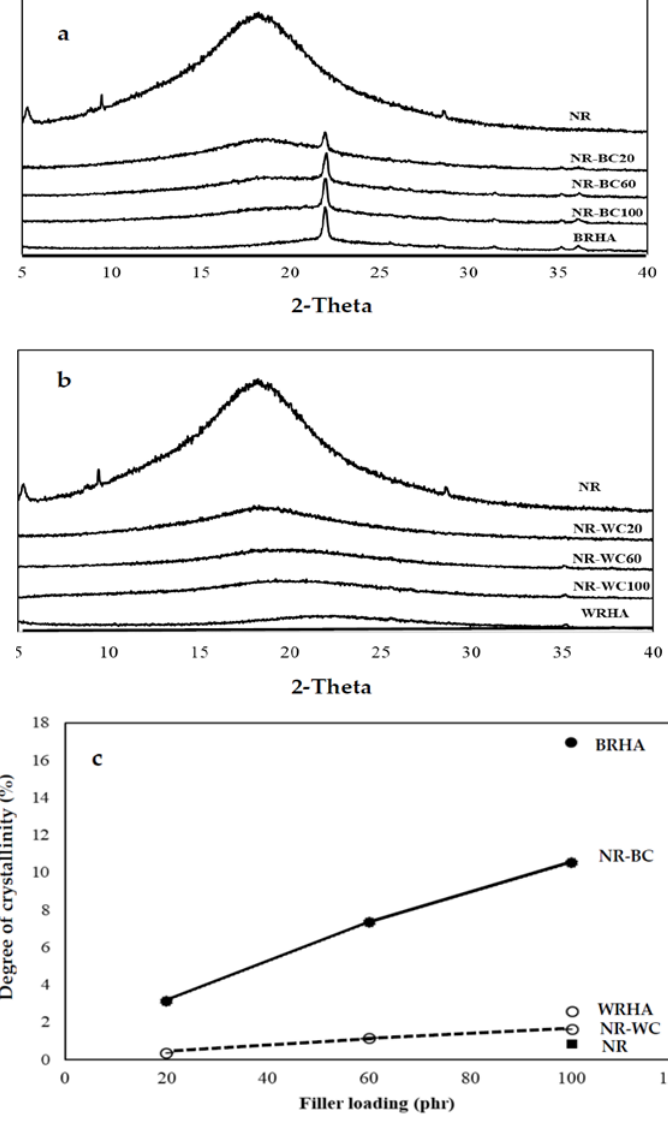
Figure 2. X-ray diffraction of the composite films of crosslinked composite films of natural rubber (NR) combined with BRHA (NR–BC) ( a ) and with WRHA (NR–WC) ( b ) and degree of crystallinity ( c ) with loaded content of BRHA and WRHA at 0, 20, 60 and 100 per hundred rubbers (phr). The particle size distributions of the BRHA and WRHA are shown in Figure 3. The BRHA particles ranged in size from 0.4 to ~ 100 μm, with an average size ≈ 6 μm. The d10, d50 and d90 values based on the volume distribution were 1.5, 6.2 and 2..5 μm, respectively. The WRHA particles ranged in size from 0.4 to 144 μm, with an average size ≈ 40 μm. The d10, d50 and d90 of WRHA were higher than those of BRHA (1.9, 17.. and 70.4 μm, respectively). The results from the SEM observation (Figure 1) and the particle size distribution (Figure 3) indicated that an average particle size of WRHA was larger